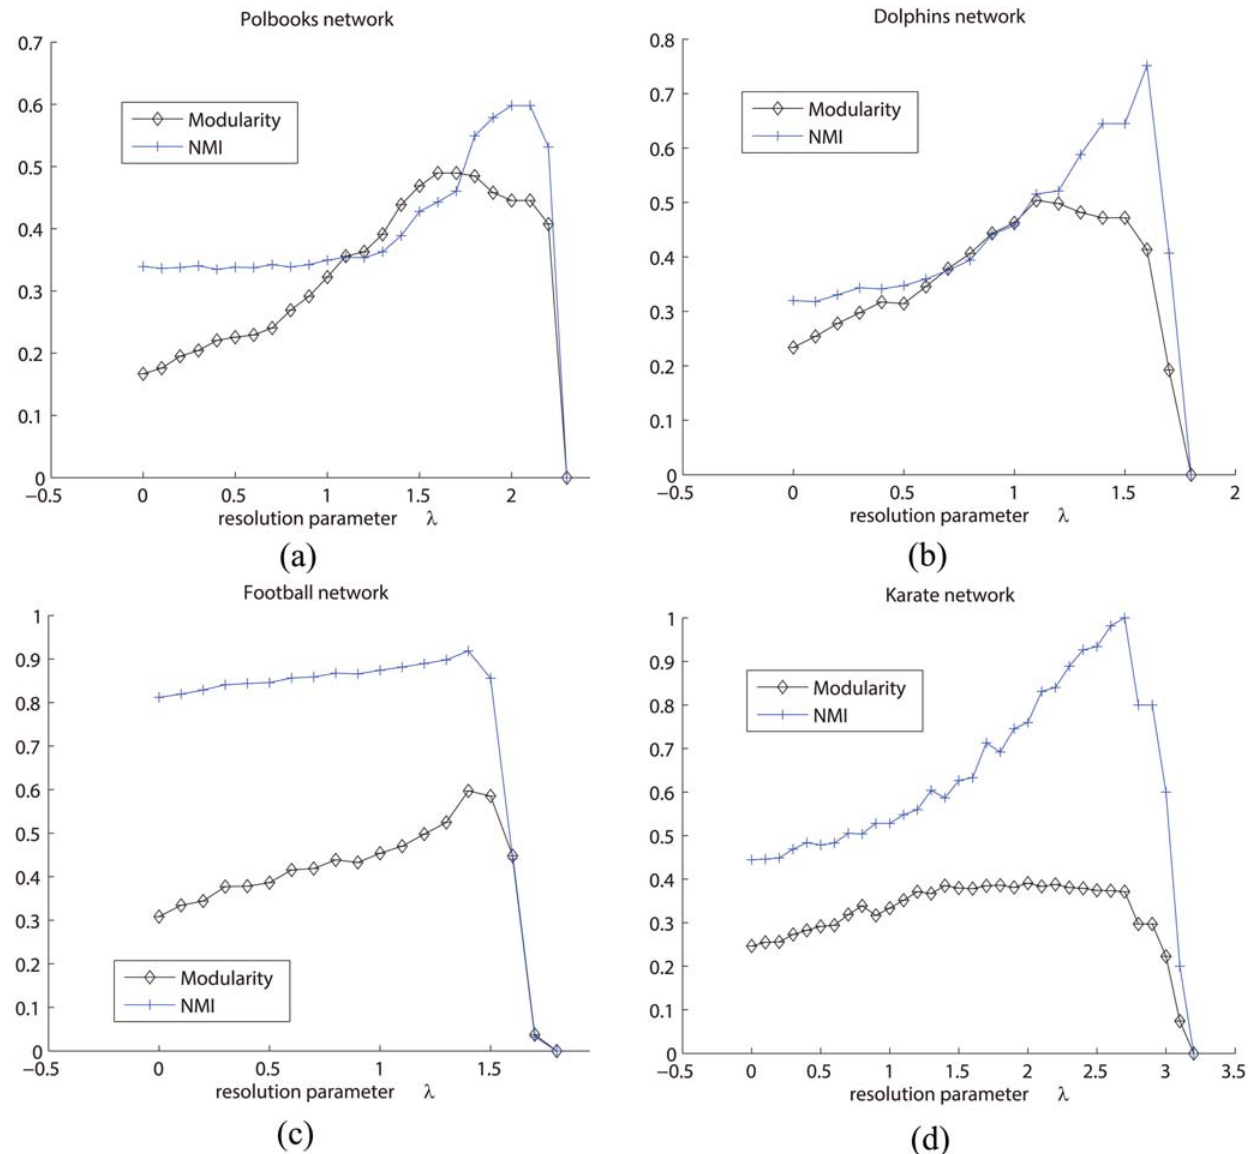
Fig 12. The qualities of communities at different scales. X-axis indicates the resolution parameter λ , and Y-axis indicates the modularity and normalized mutual information (NMI) (a) The values of modularity and NMI on polbooks network; (b) The values of modularity and NMI on dolphins network; (c) The values of modularity and NMI on football network; (d) The values of modularity and NMI on karate network.